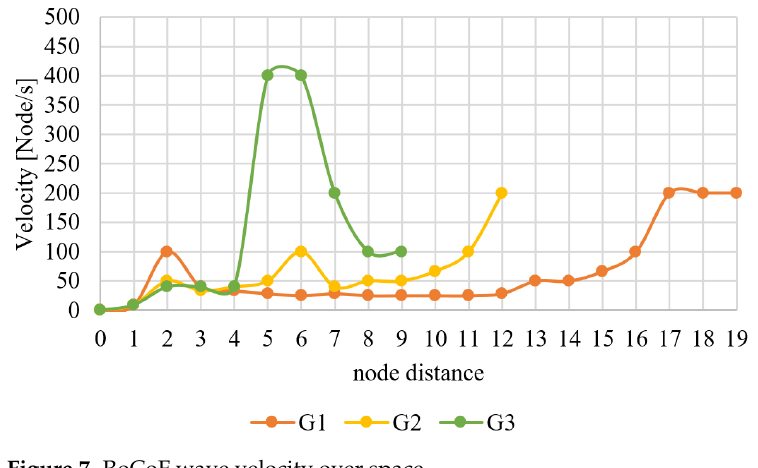
Figure 7. RoCoF wave velocity over